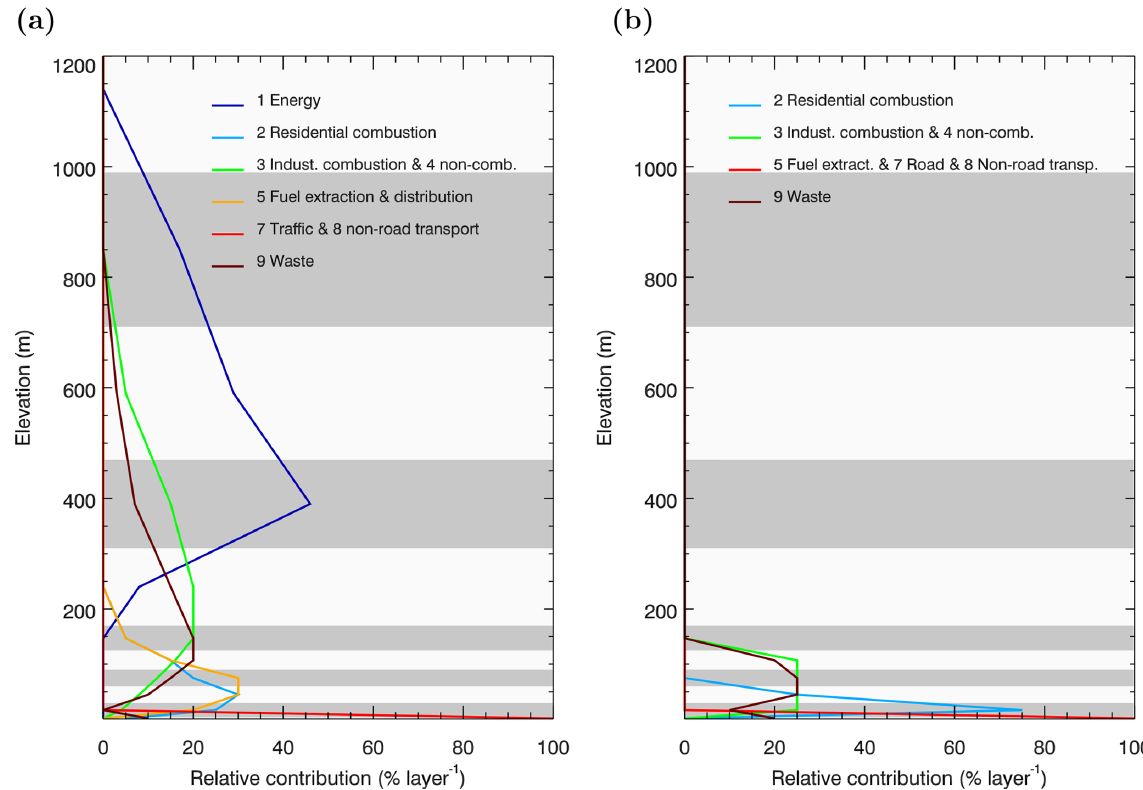
Figure 2. Vertical emission profiles applied for (a) point sources and (b) area/line sources. The alternating gray and white backgrounds denote the vertical layers. Table 1. Stack parameters used for plume rise calculation for the six largest power plants in the model domain. Name Longitude Latitude Stack Effluent Volume flux b temperature a (K) (m 3 s − 1 )